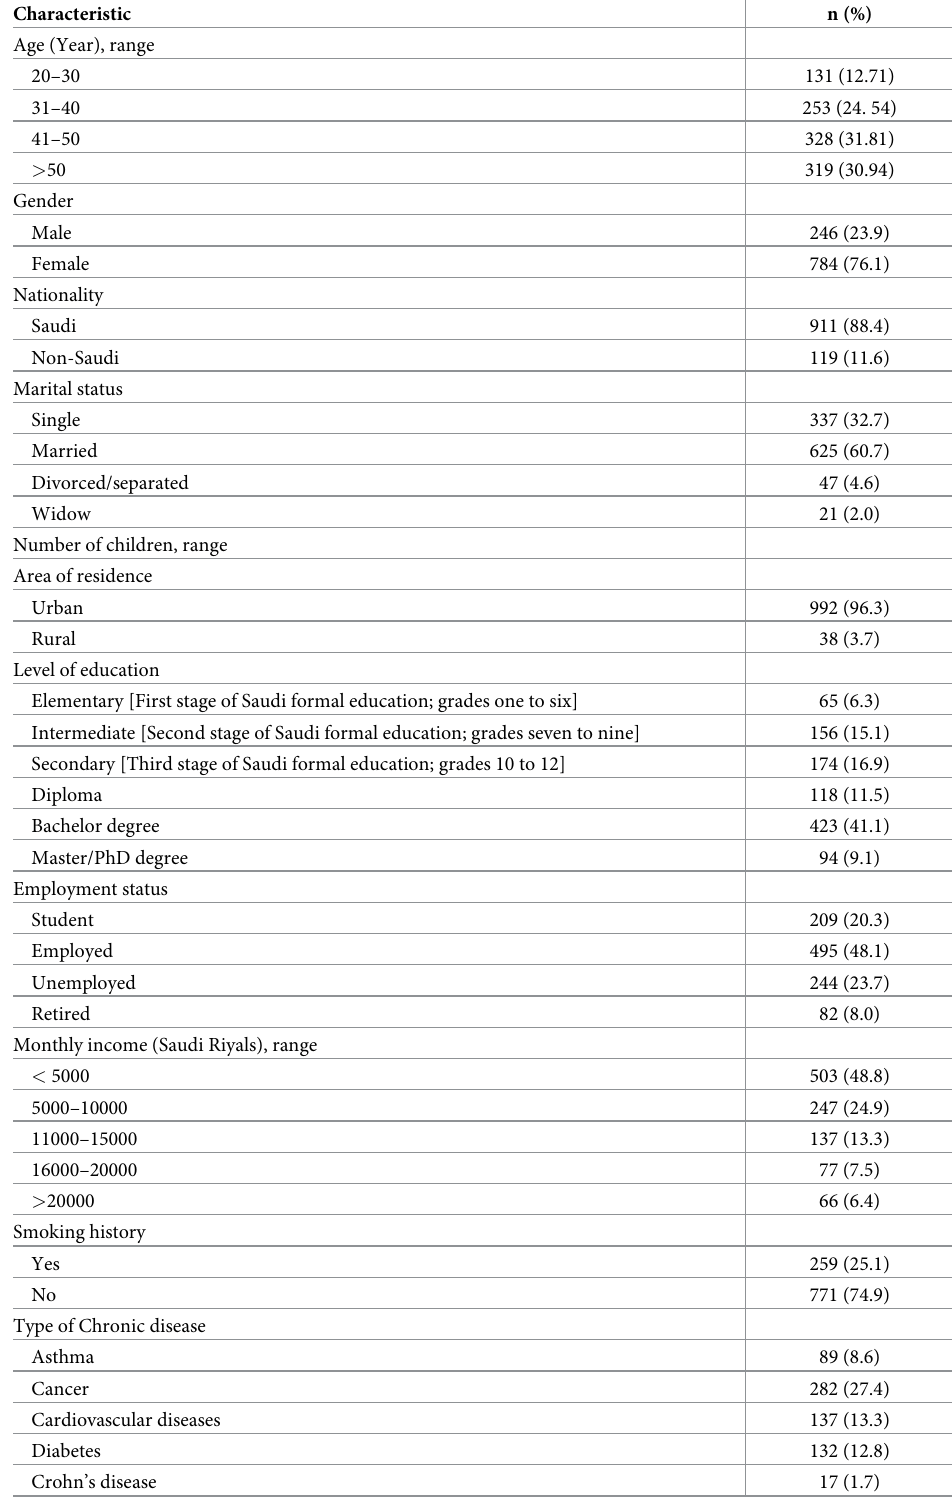
Table 1. Sociodemographic and clinical characteristics of the